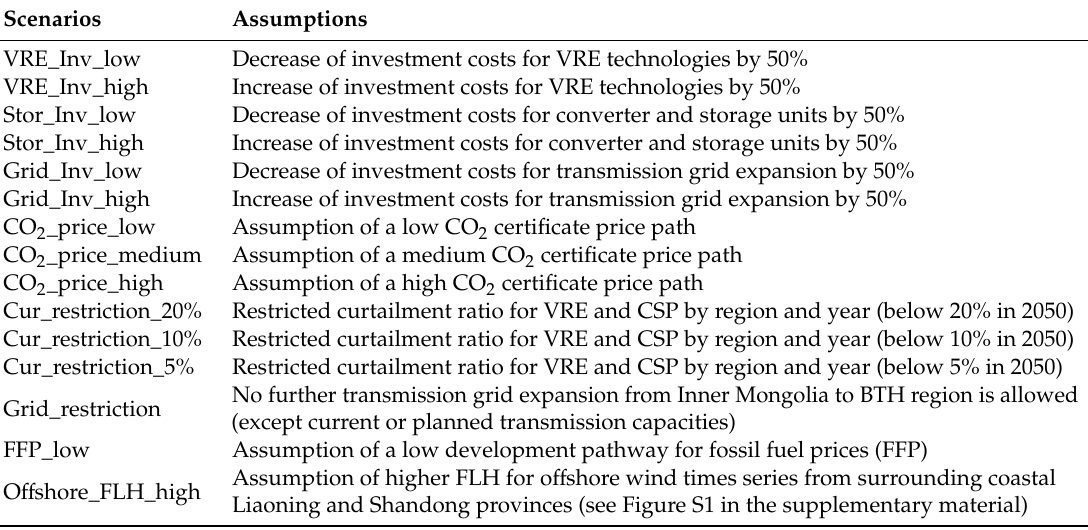
Table 10. Scenario assumptions for the sensitivity